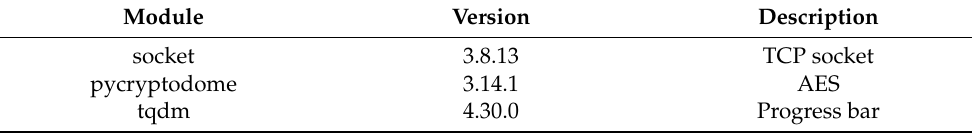
Table 8. Docker-Ubuntu extra modules for data transmission and